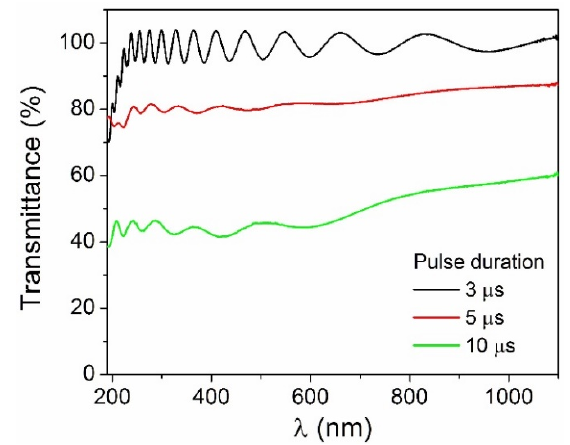
Figure 5. Optical transmittance of SiO 2 thin films deposited by reactive HiPIMS on quartz substrate with 50-nm thick SiN interlayer, for three selected pulse durations.